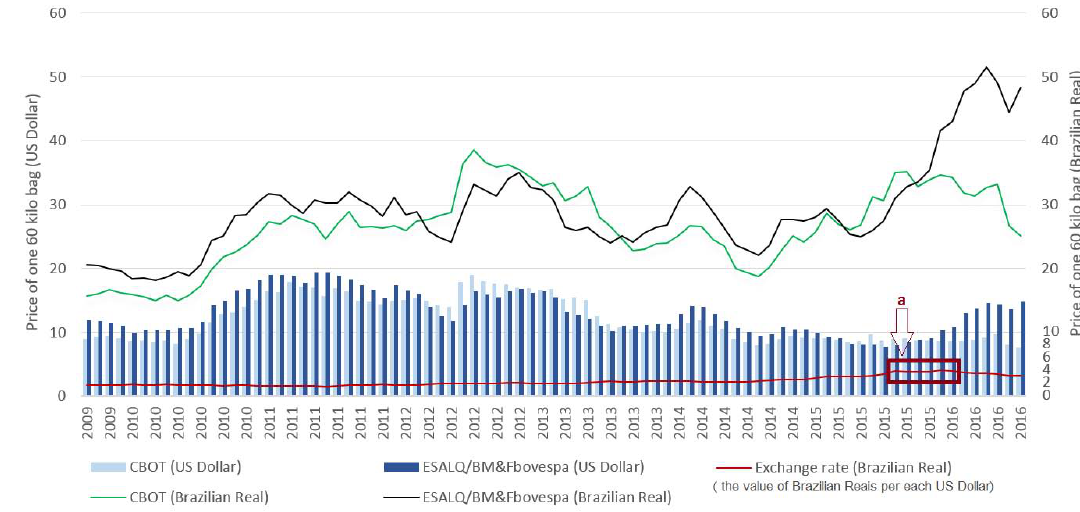
Figure 7. Historical prices of maize traded in the Brazilian internal market (Luiz de Queiroz College of Agriculture—ESALQ/BM&FBovespa) compared to the prices in the Chicago Board of Trade (CBOT). The daily exchange rate between the Brazilian currency and the US Dollar was used to present the value of one 60-kilo bag of maize (Cepea and CBOT, Supplementary Material